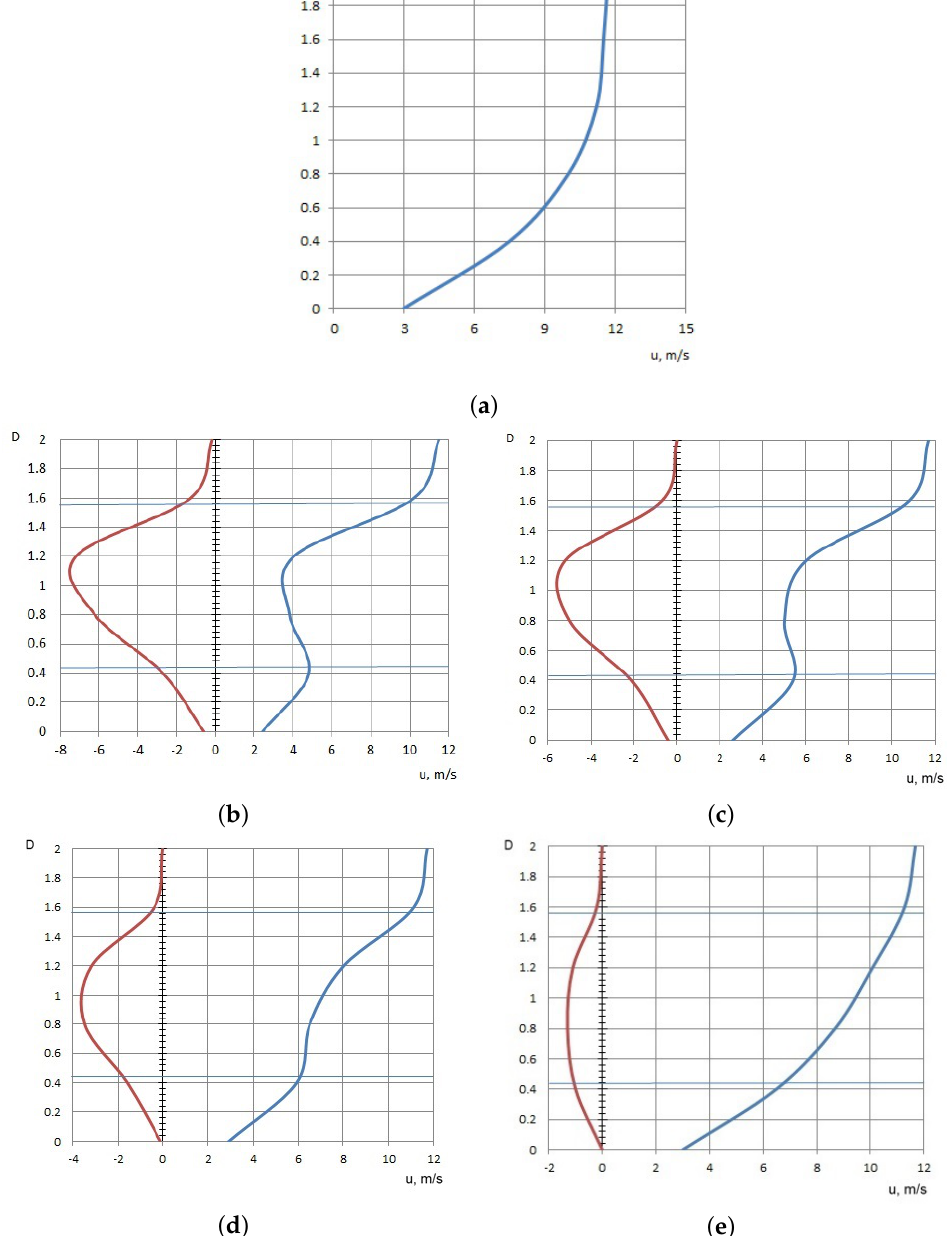
Figure 9. Velocity gradients before and behind the wind turbine. ( a ) velocity gradient before the wind turbine; ( b ) velocity gradient behind the wind turbine at D = 2; ( c ) velocity gradient behind the wind turbine at D = 4; ( d ) velocity gradient behind the wind turbine at D = 6; ( e ) velocity gradient behind the wind generator at D = 8 (D is the distance in diameters of the wind turbine blades). The turbulence intensity was also estimated σ u / u in the impact zone of the wind turbine. Figure 10 shows the results of modeling the turbulence profile in the wind tur- bine